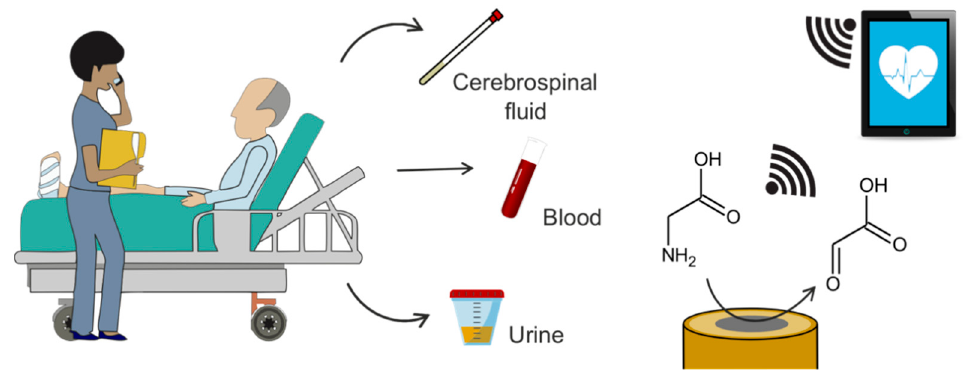
Figure 2. Graphic concept of electrochemical glycine determination in the clinical field. Glycine is analyzed in CSF, blood or urine through its electrochemical oxidation and the obtained data are transferred wirelessly to a phone/tablet.